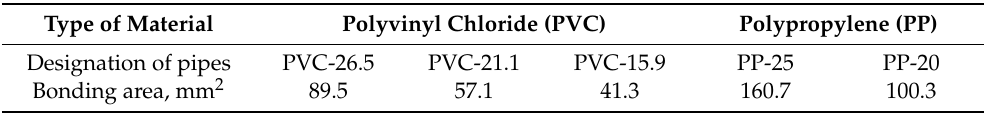
Table 3. Dimension of adhesive bonding area.